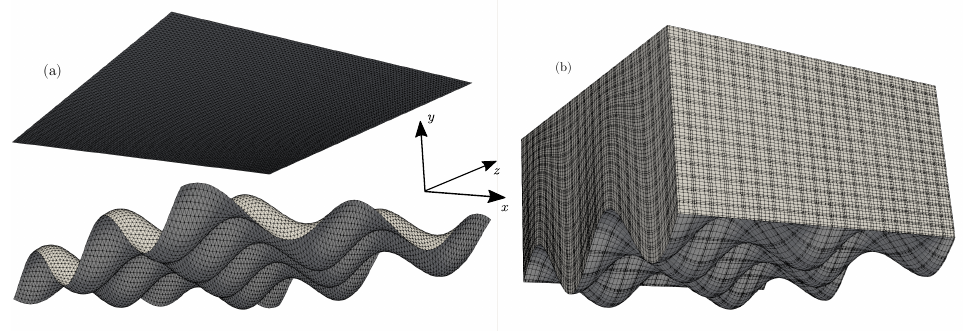
Figure 10. ( a ) STL triangulation corresponding to the semi-wavy configuration in x and y directions considered for the simulations, ( b ) computational domain used in Nek5000.